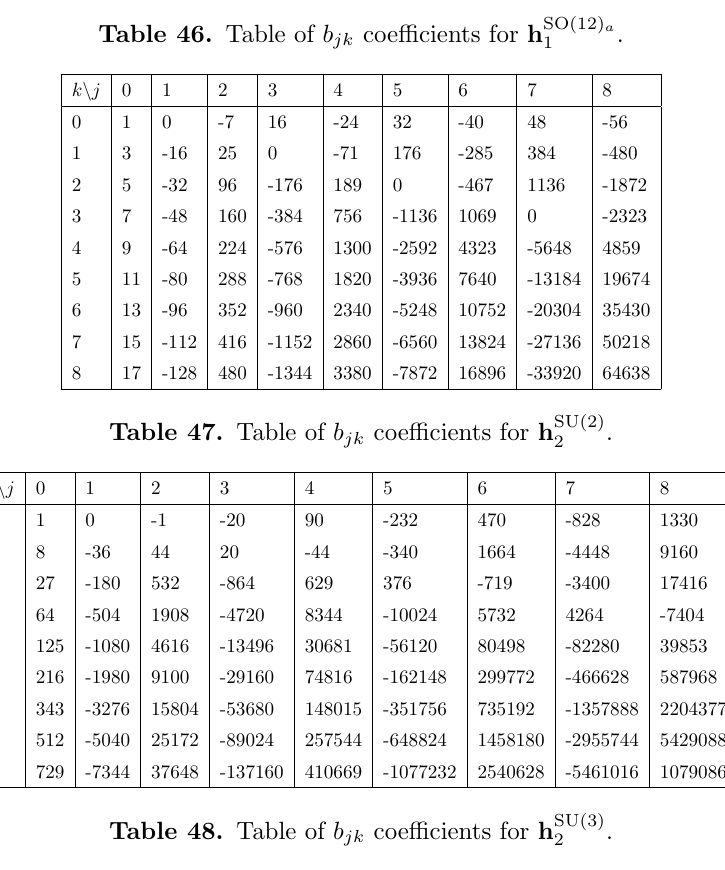
Table 46. Table of b jk coe(cid:14)cients for h SO(12) a